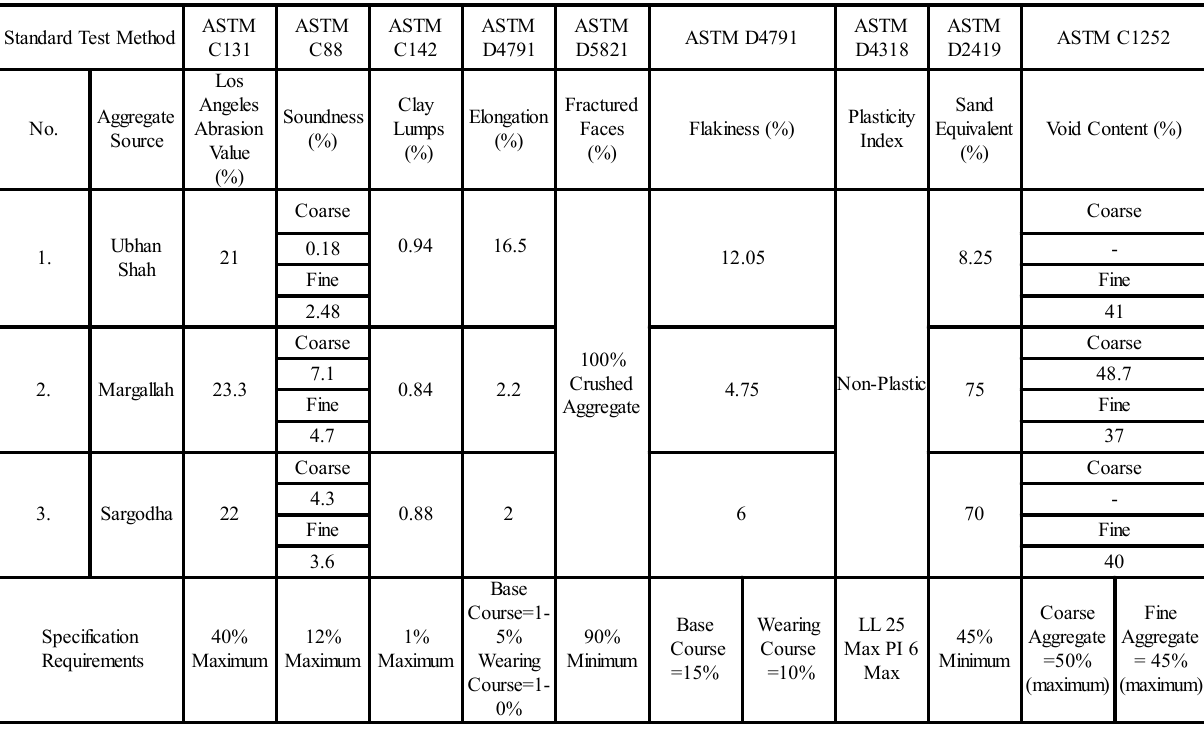
FIG. 1. FLOWCHART FOR EXPERIMENTAL PROGRAM TABLE 1. QUALITATIVE TESTS OF